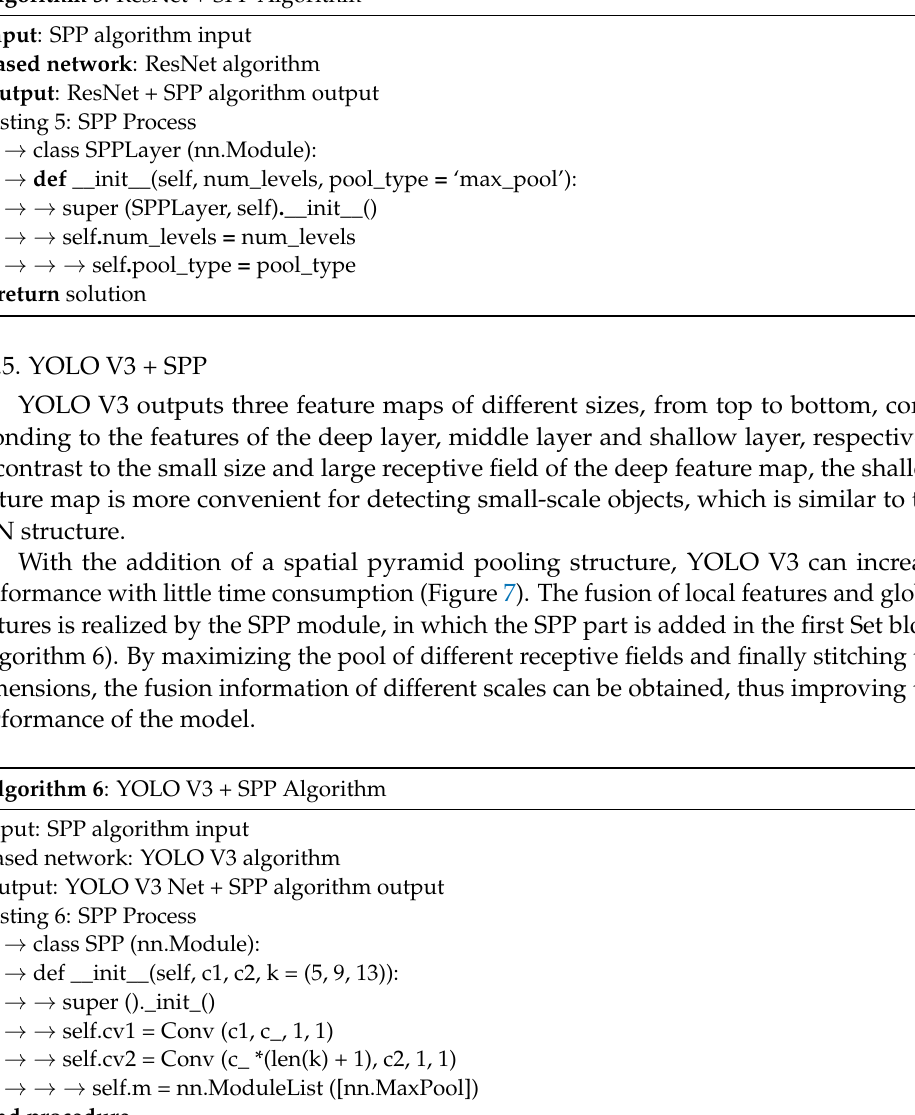
Algorithm 5 : ResNet + SPP Algorithm